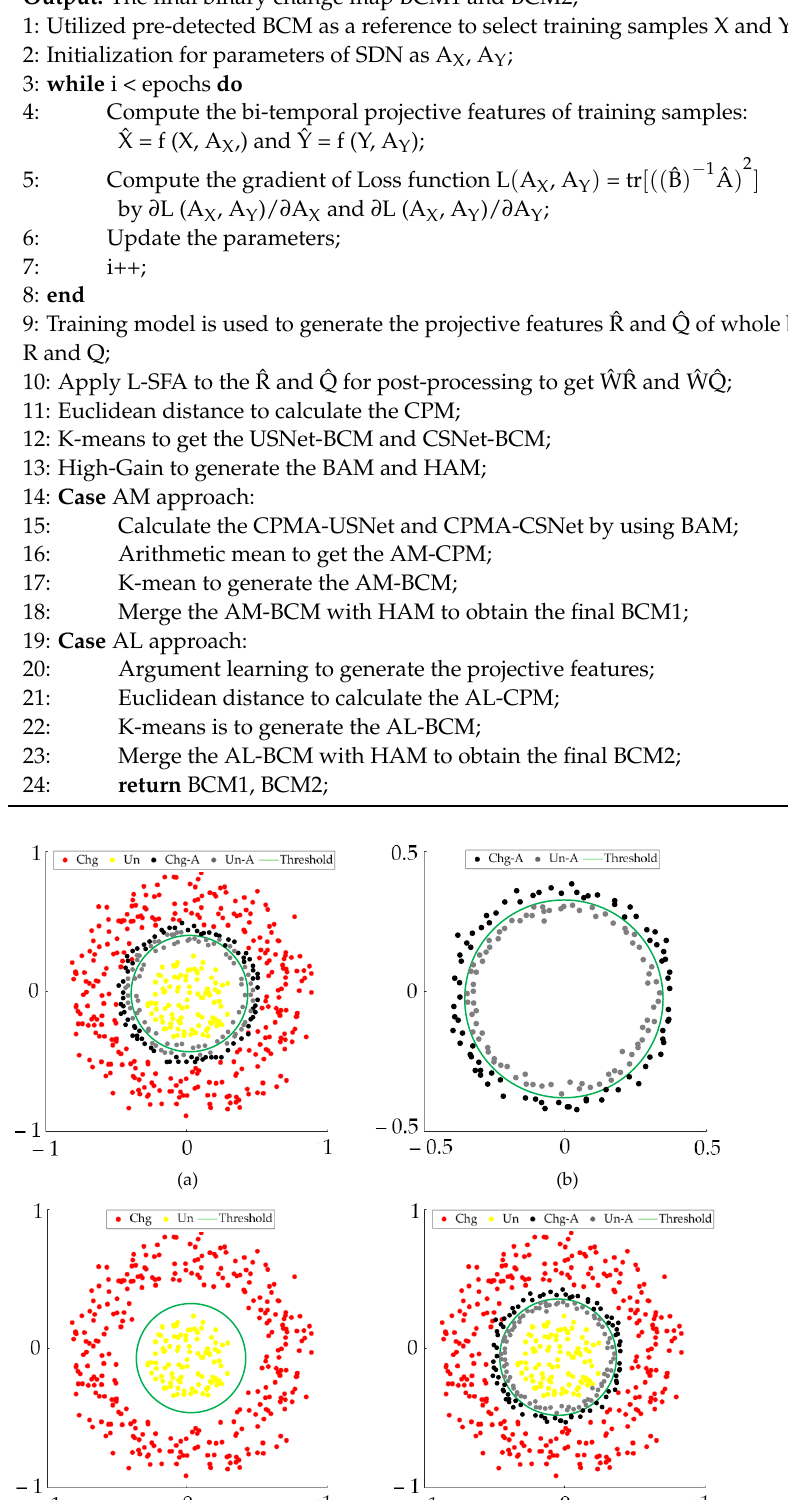
Algorithm 1 The executive process of proposed CD-SDN to generate the final binary change map